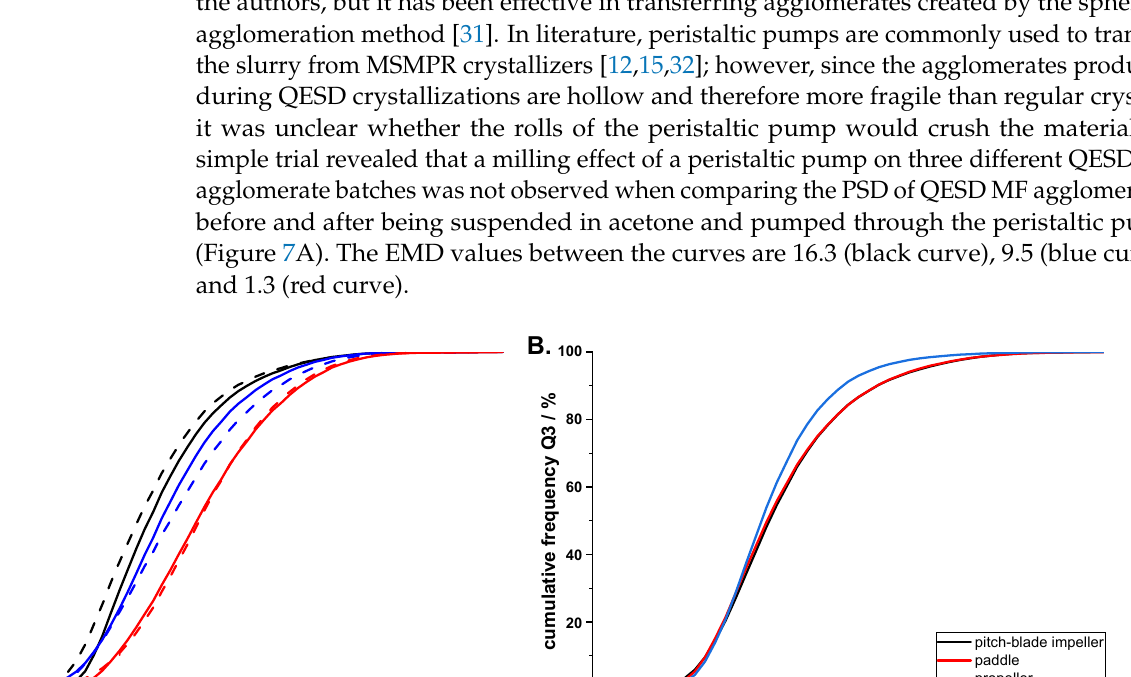
. V out = 23.8 mL/min,